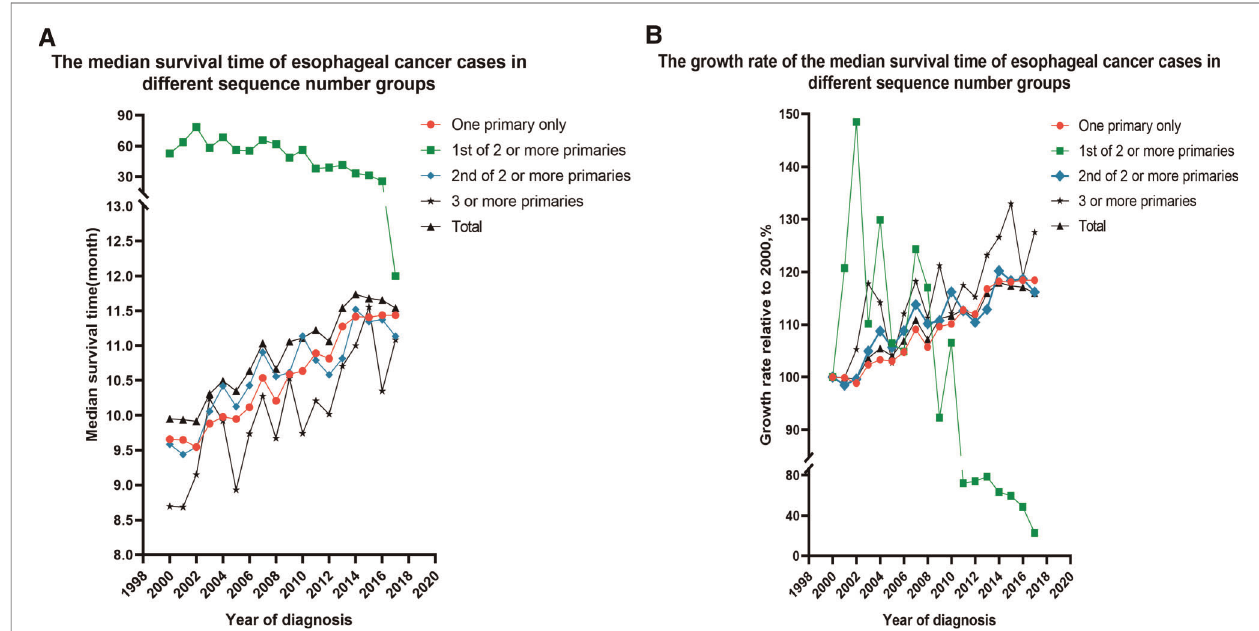
FIGURE 1 | Changes to the median survival time and the growth rate of median survival time in patients with esophageal cancer from 2000 to 2017, according to the sequence number. ( A ) Changes in median survival time. ( B ) Changes in growth rate.